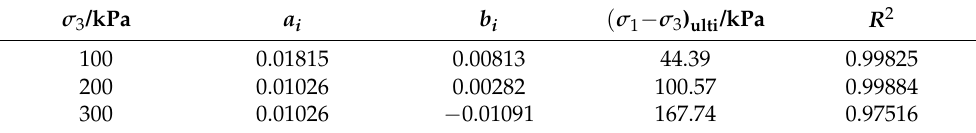
Table 4. Fitting